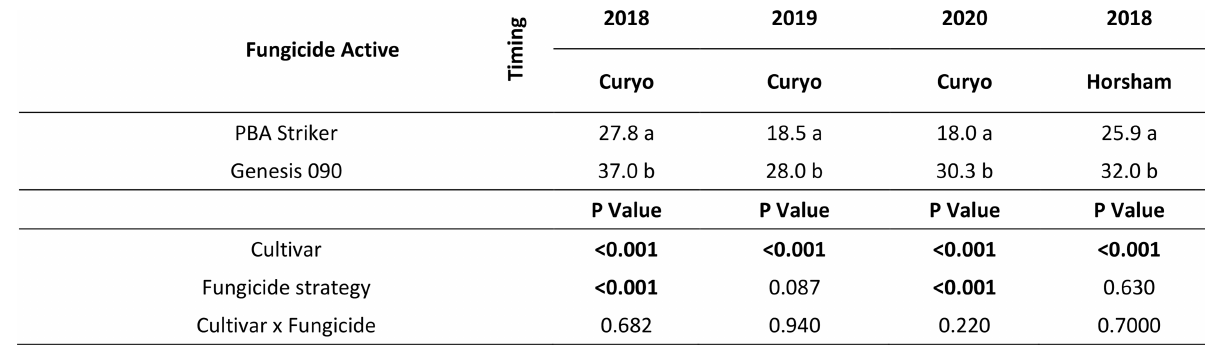
TABLE 9 Grain weight (g/100 grains) differences between cultivars in the fungicide by cultivar experiments at Curyo in 2018 and 2019 and Horsham in 2018.